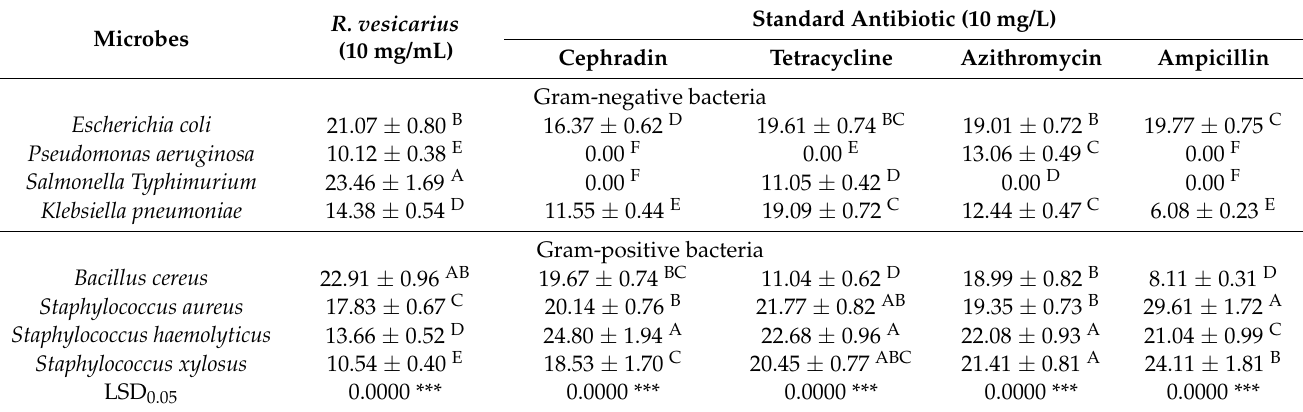
Table 3. Antibacterial activity of the methanol extract from the aerial parts of R. vesicarius and some selected reference antibiotics at a concentration of 10